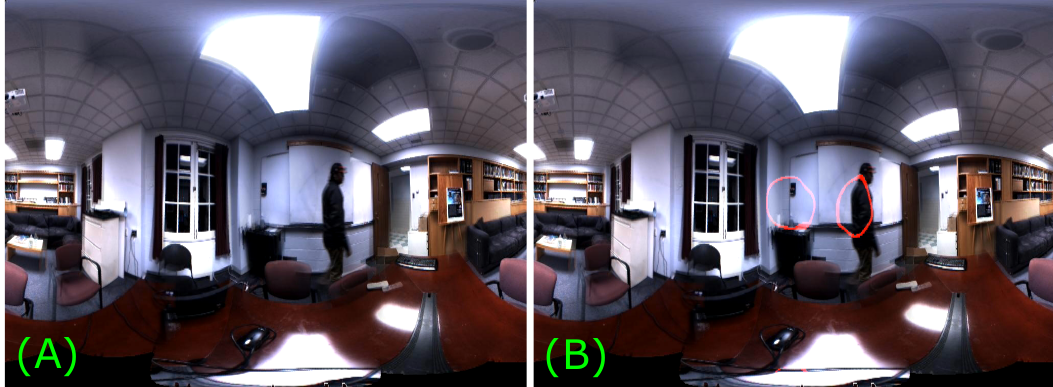
Figure 7. Visualization of results with isocontours: ( A ) input Frame #77 of Dataset 2; and ( B ) the red contour superimposed on the same input frame is the isocontour of salience values. All values along the red line are equal to the threshold value. Anything inside the closed red isocontour has a salience value greater than